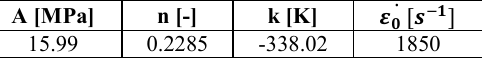
Table 1. Perfect plasticity model